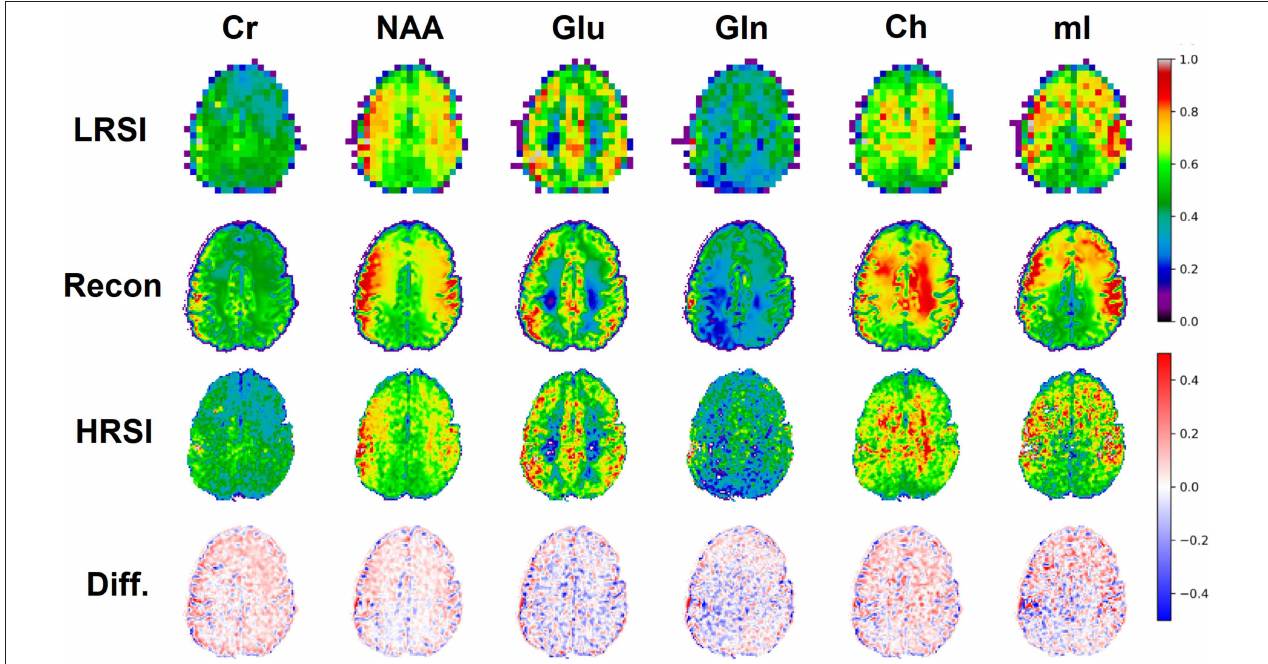
FIGURE 8 | An in vivo example of a healthy volunteer is used to demonstrate the potential application for the D-UNet. The experimental high resolution SI (HRSI) data was acquired at 128x128 resolution using an accelerated acquisition protocol ( 20). This data was then down-sampled to produce 32x32 low resolution SI (LRSI) metabolite maps for Cr, NAA, Glu, Gln, Ch, and mI. Together with the T1w image, the low resolution metabolite images were used to reconstruct high resolution spectroscopic images (Recon) using the 32x32 D-UNet model. The difference maps between the Recon and HRSI images (Diff) are also shown.